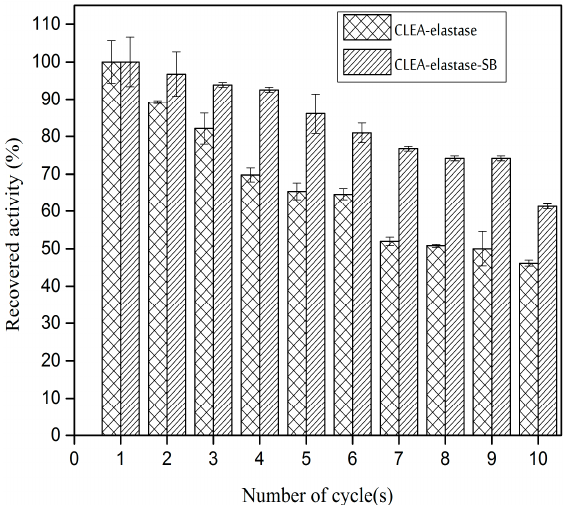
Figure 7. Reusability of CLEA–elastase and CLEA–elastase–SB. The experiment was conducted in triplicate and recovered activities are presented as mean values ± standard error.